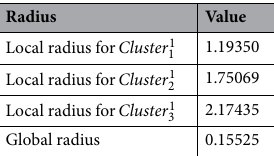
Table 15. Event horizon computation.